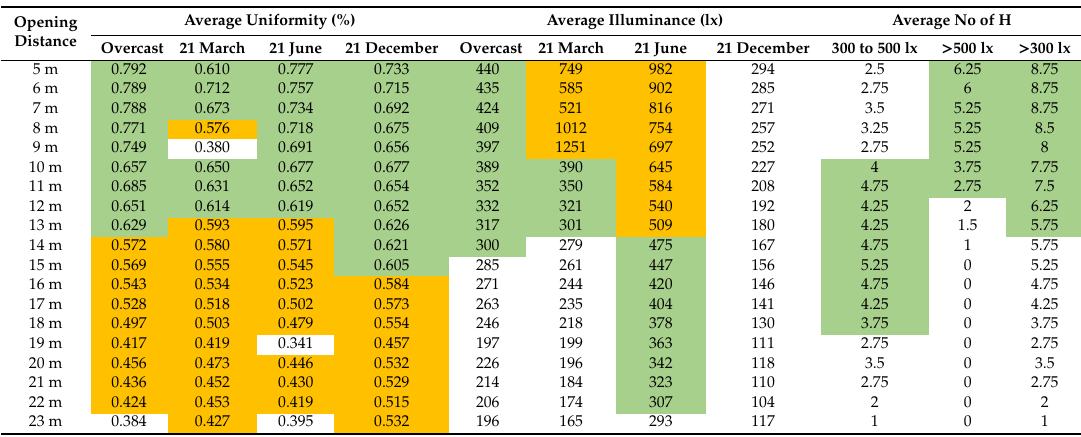
Table 10. Hourly average uniformity, illuminance and hours of su ffi cient lighting values for various distance steps between two consecutive openings (Green colour: The target value is fully fulfilled. Orange colour: The target value is partially